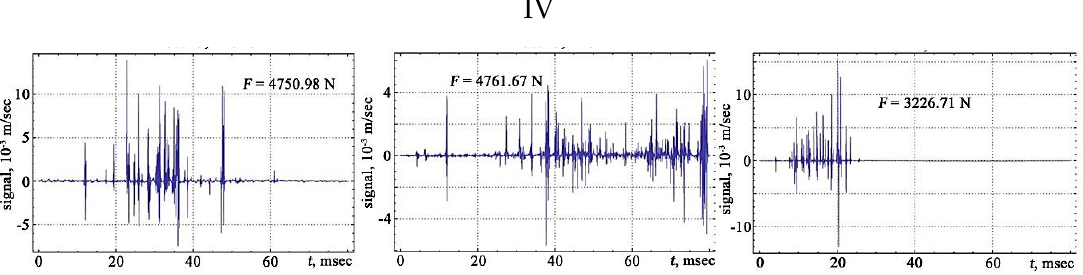
Figure 9. The vibration signals in different parts of the chart of stretching: IV—phase prior to the rupture of the sample